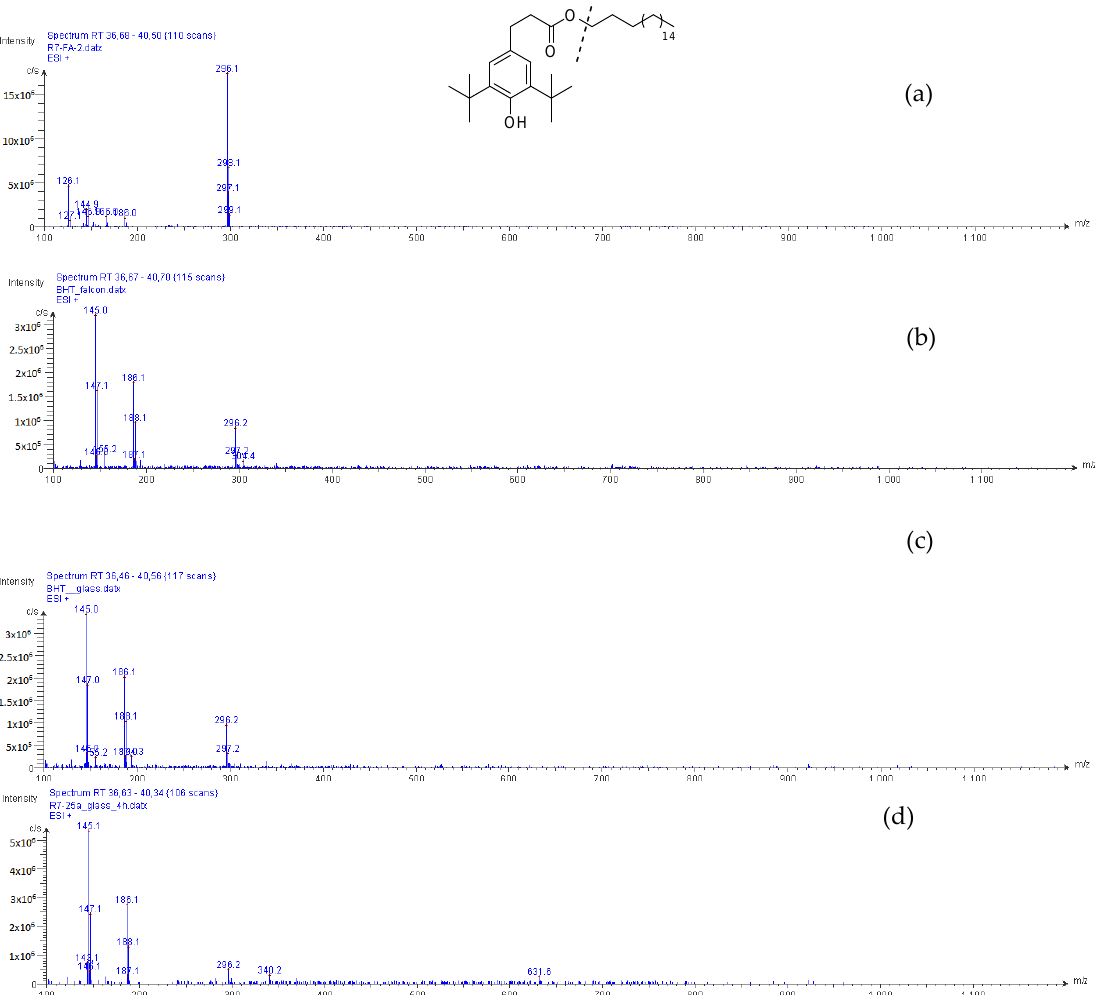
3-(4,5-dimethylthiazol-2-yl)-2,5-diphenyltetrazolium bromide (MTT) assay on HaCaT (human keratinocytes) and B16 (murine melanoma) cell lines (Table 3) [19]. Although neither compound